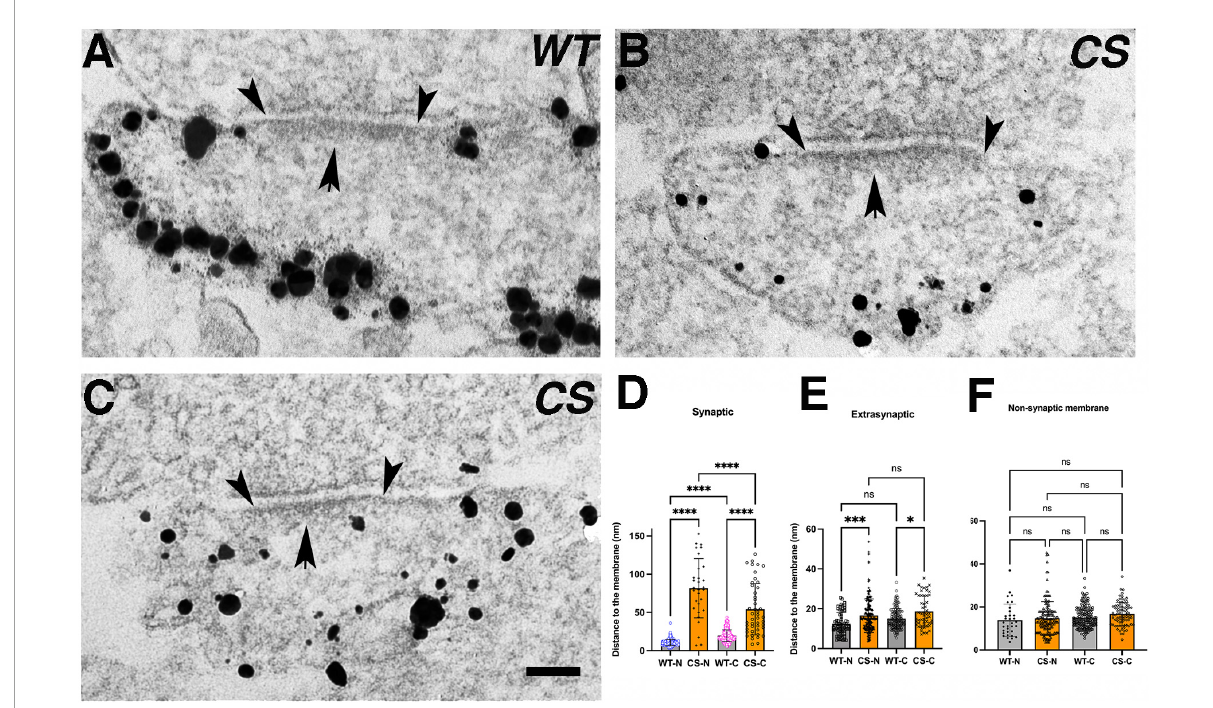
FIGURE5 Palmitoylation effects on nano-scale localization and molecular configuration of AKAP79 in rat hippocampal spine synapses determined by immunogold EM. (A) Electron micrograph of immunogold labeled overexpressed WT AKAP79-GFP (C-terminally GFP tagged) at a spine synapse. Arrowheads delineate the outer edges of the PSD, arrow points to the PSD. (B,C) Electron microgram of immunogold labeled overexpressed CS AKAP79-GFP at a spine synapse. Scale bar 100 nm. (D–F) Histograms comparing immunogold to the membrane distance between WT and CS in synaptic, extrasynaptic zones, and non-synaptic membrane for N-terminally GFP tagged AKAP79 (WT-N, CS-N) or C-terminally GFP tagged AKAP79 (WT-C, CS-C). ANOVA, Tukey test: 11 ± 4 nm (range 3.5–36 nm, CV = 0.36, N = 280, GFP-N, WT), 82 ± 39 nm (range 7–153 nm, CV = 0.48, N = 30, GFP-N, CS, **** p < 0.0001); 20 ± 8 nm (range 5–43 nm, CV = 0.4, N = 424, C-GFP, WT), 54 ± 34 nm (range 9–126 nm, CV = 0.63, N = 46, C-GFP, CS, **** p < 0.0001). 12 ± 6 nm (range 4–25 nm, N = 68, CV = 0.5, GFP-N, WT), 17 ± 8 nm (range 4–53 nm, N = 180, CV = 0.47, GFP-N, CS, *** p = 0.0004); 15 ± 5 nm (range 5–33 nm, N = 175, CV = 0.33, C-GFP, WT), 19 ± 8 nm (range 7–35 nm, N = 53, CV = 0.42, C-GFP, CS, * p = 0.013). 14 ± 7 nm (range 4–37 nm, N = 33, CV = 0.5, GFP-N, WT), 15 ± 8 nm (range 5–33 nm, N = 155, CV = 0.53, GFP-N, CS, P = 0.9962); 15 ± 5 nm (range 5–33 nm, N = 175, CV = 0.33, C-GFP, WT), 17 ± 5 nm (range 5–34 nm, N = 83, CV = 0.29, C-GFP, CS, P = 0.4818). * p ≤ 0.05, *** p < 0.001, **** p < 0.0001, ns p >